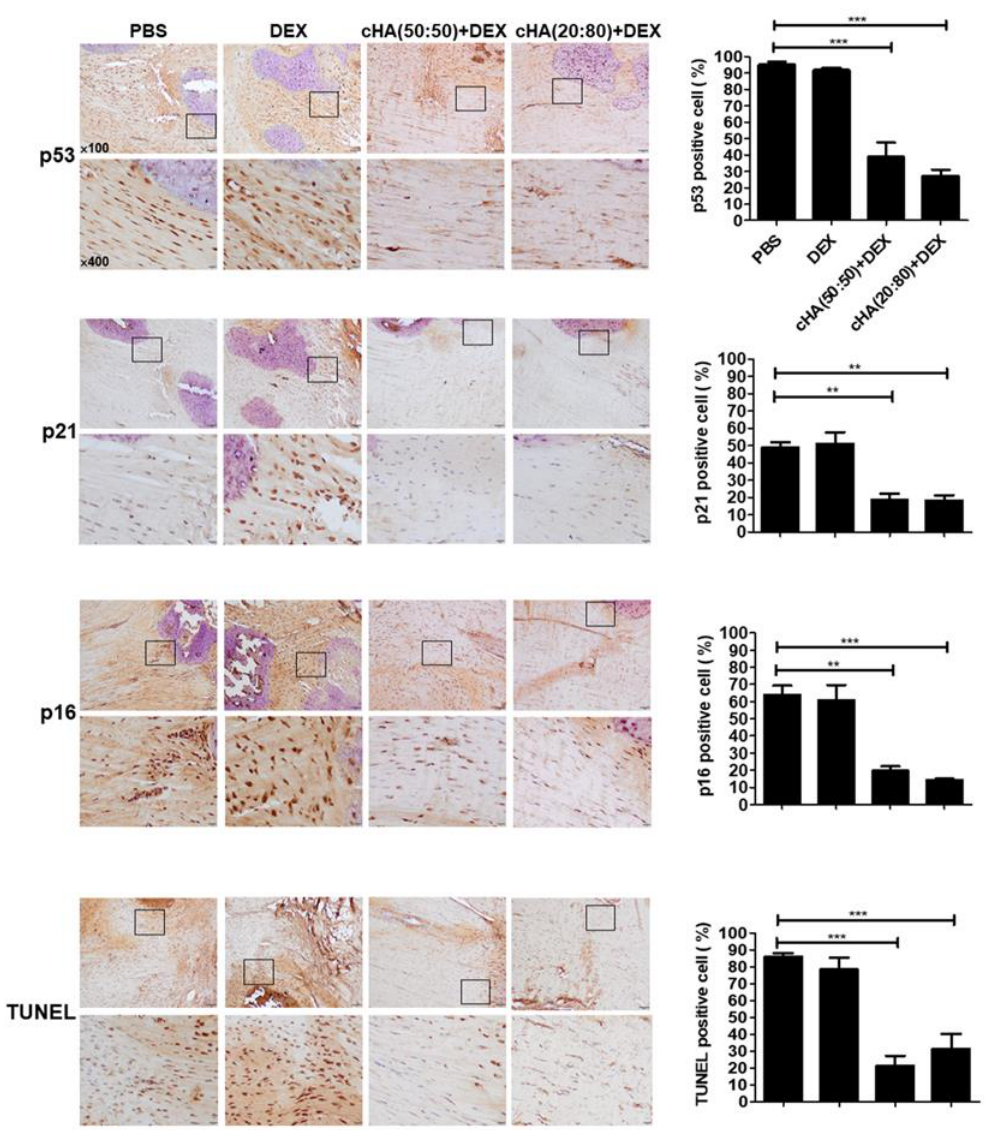
Figure 6. Immunohistochemistry of senescence-related markers and TUNEL analysis in the experi- mental rat model. Eight weeks after the intratendinous collagenase injection, the rats were scarified for further analysis. Immunohistochemical stainings and quantitative analysis of p53, p21, p16, and TUNEL were performed in the patellar tendons treated with PBS, DEX, cHA (50:50) + DEX, and cHA (20:80) + DEX. Bars shown at × 100 and × 400 magnifications correspond to 50 and 20 µ M. Values are the mean ± SEM. ** p < 0.01, *** p < 0.001.